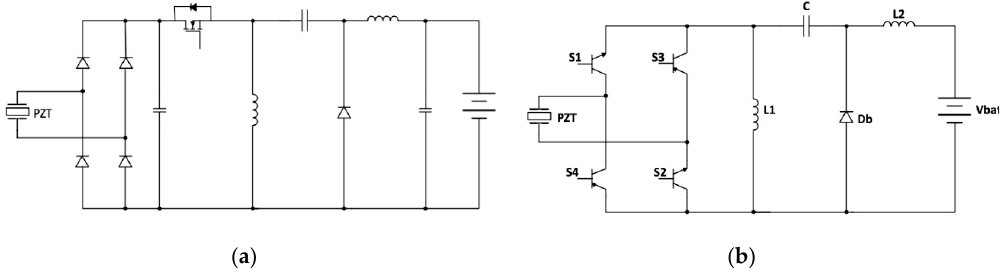
Figure 5. Power conversion circuits based on a diode rectifier and a standard Zeta converter: ( a ) two-stage converter and ( b ) proposed single-stage converter.